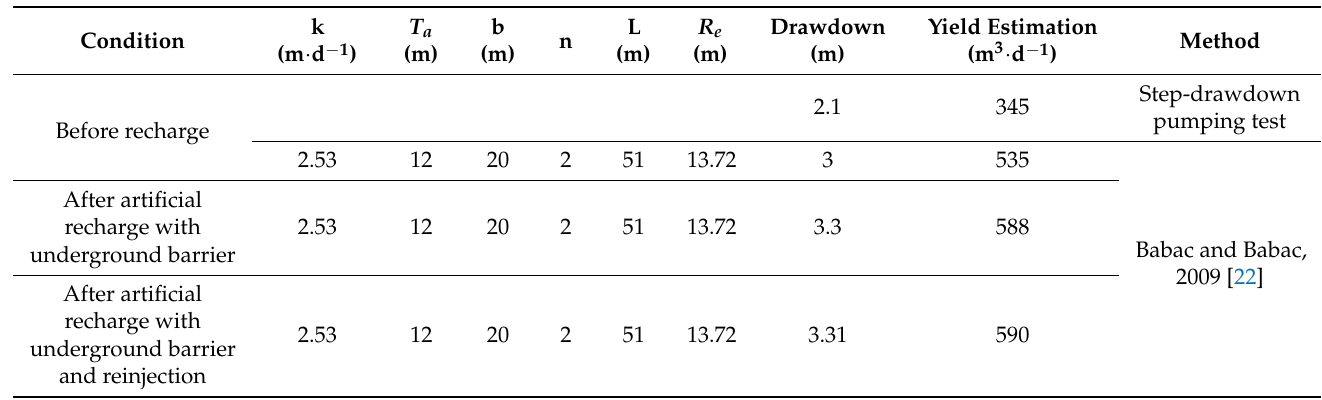
Table 3. Result of yield estimation at the horizontal collector well by Babac and Babac (2009) and pumping